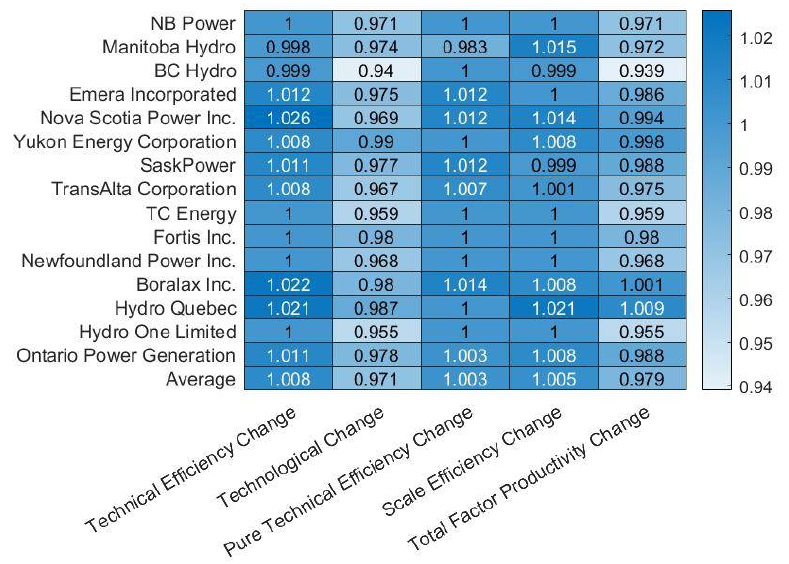
Figure 7. Geometric mean of the company-wise MPIs.